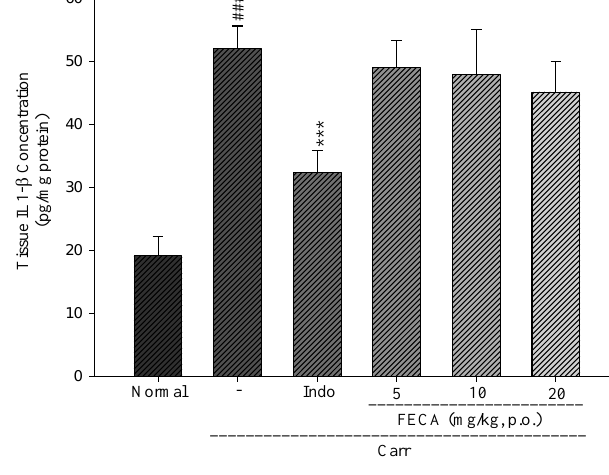
Figure 4. Effects of FECA and Indo on the tissue IL-1β concentration of edema paw in mice. Each value was represented as mean ± S.E.M. ### p < 0.001 as compared with the normal group; ** p < 0.01 as compared to the λ-carrageenan (Carr.) group (one-way ANOVA followed by Scheffe’s multiple range